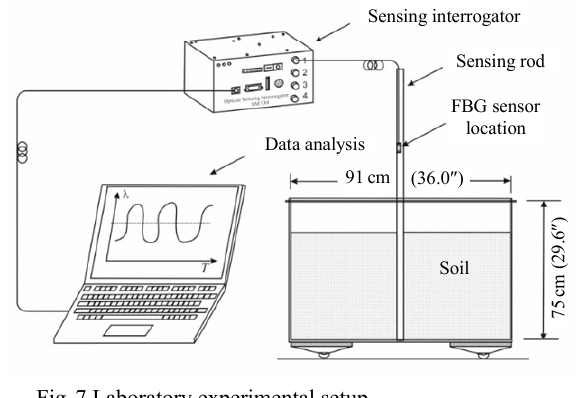
Fig. 7 Laboratory experimental setup.